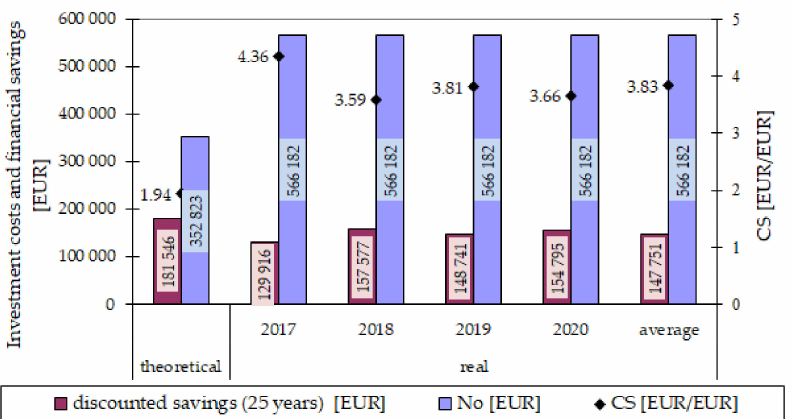
Figure 16. Financial outlays and savings as well as the CS index of deep thermomodernization carried out in the analyzed building.